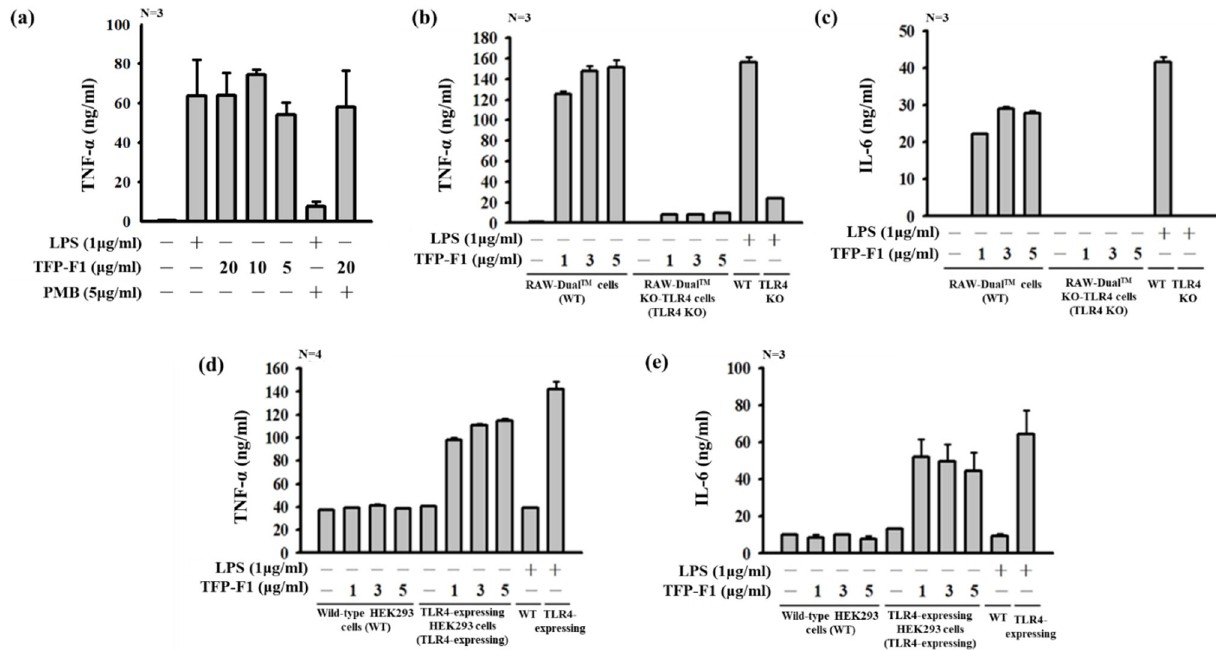
Figure 3. Immunomodulatory activity of TFP-F1. J774A.1 macrophage cells were incubated for 24 h with or without different concentrations of TFP-F1 or LPS (1 µ g/mL). ( a ) Induction of TNF- α secreted by TFP-F1 (5, 10, and 20 µ g/mL) in J774A.1 macrophage cells. ( b , c ) Wild-type RAW-Dual TM cells and RAW-Dual TM KO-TLR4 cells were incubated with or without different concentrations of TFP-F1 (1, 3, and 5 µ g/mL) or LPS (1 µ g/mL). The levels of ( b ) TNF- α and ( c ) IL-6 in the RAW-Dual TM KO-TLR4 cells. ( d , e ) Wild-type HEK293 cells and TLR4-expressing HEK 293 cells were incubated for 24 h with or without different concentrations of TFP-F1 (1, 3, and 5 µ g/mL) or LPS (1 µ g/mL), and the level of ( d ) TNF- α and ( e ) IL-6 were measured by ELISA.